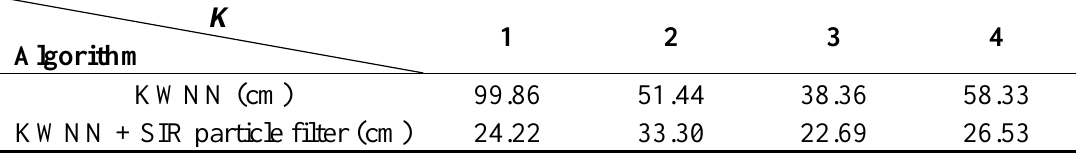
Table 1. Standard deviations of positioning errors of the dynamic test using the KWNN algorithm and the KWNN algorithm with the SIR particle